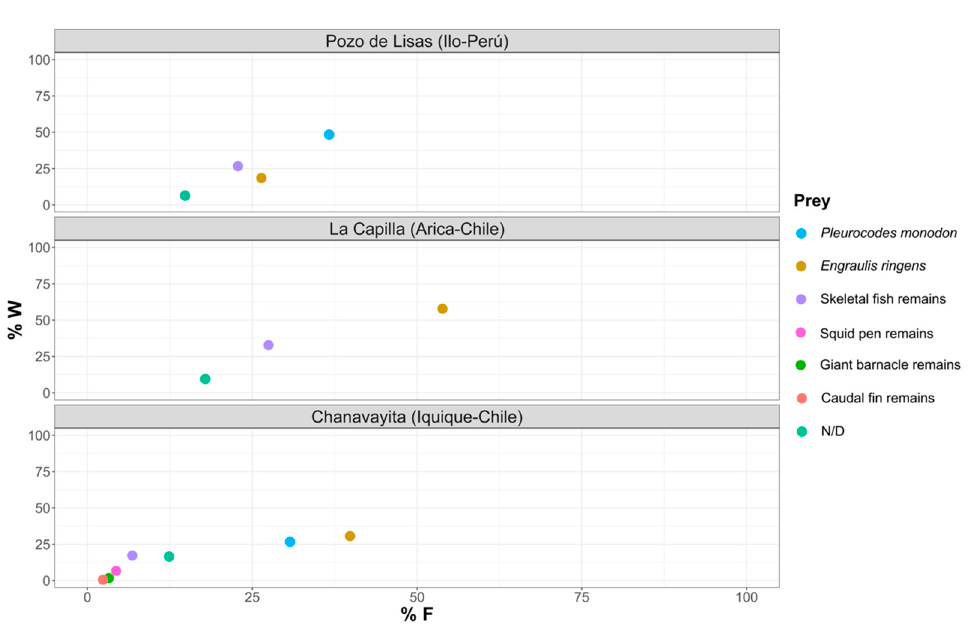
Table 5. Shannon’s dietary diversity values (H ′ ), Shannon´s maximum diversity (Hmax), and diet homogeneity (J ′ ).